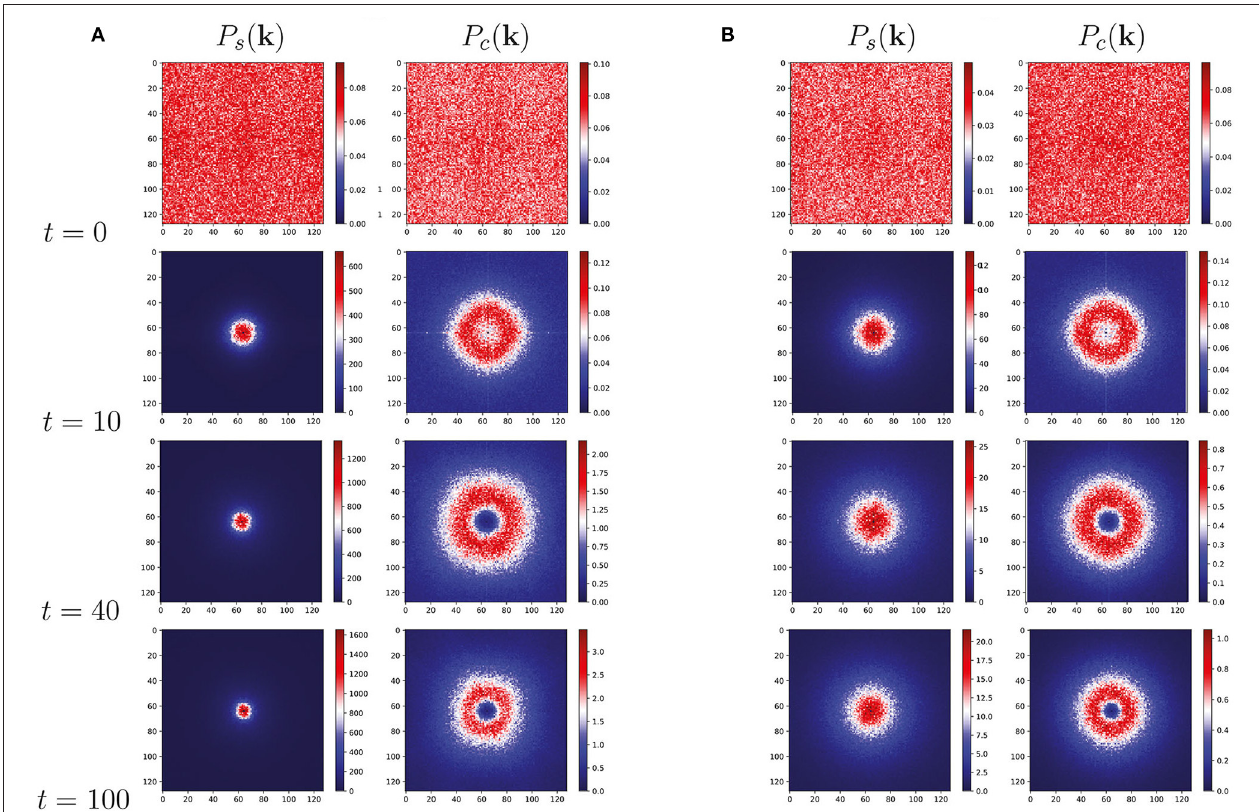
FIGURE 3 | Time evolution of the power spectra of the nematization P s ( k ) and the concentration P c ( k ) from (A) the scalar Equations (9) and (B) the tensor Equations (14). As the time increases, the power is concentrated at ever smaller wave numbers k time. Also, the conserved-field power spectra P c ( k ) show clear maxima at intermediate wavenumbers, with noticeable smaller values at the origin. Parameters R 0.1, g 0.005, r 1, c 0 0.01 were fixed through the = = = − =